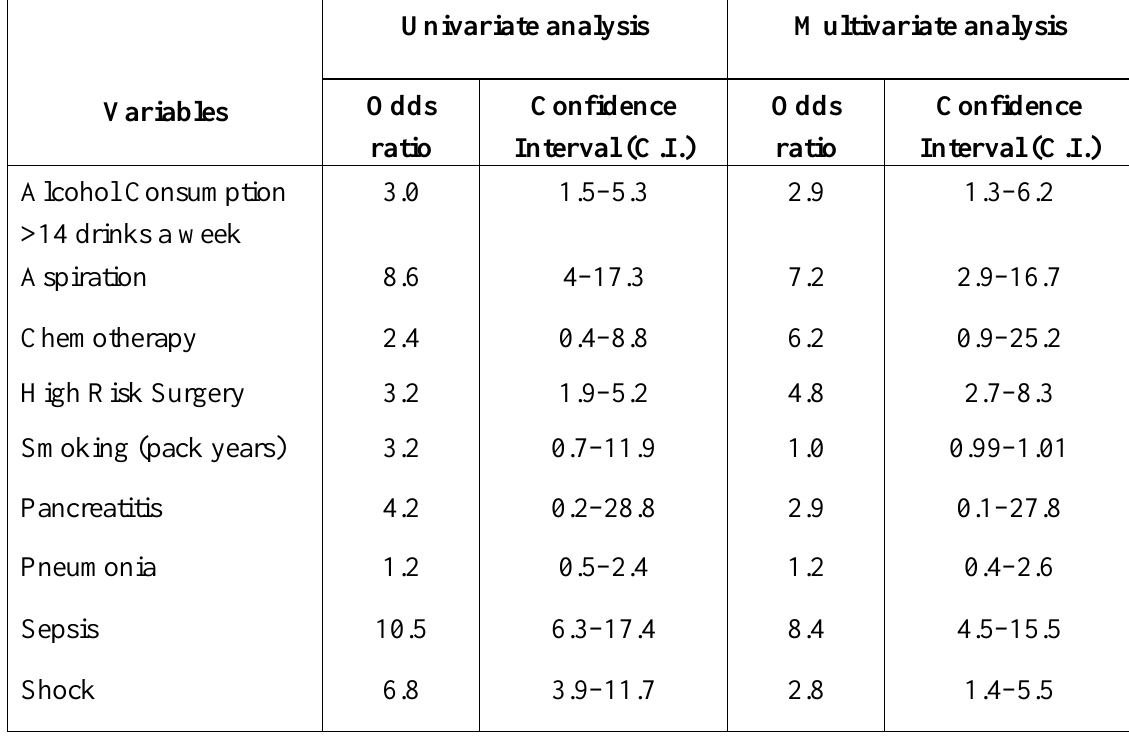
Table 2. Factors associated with ARDS